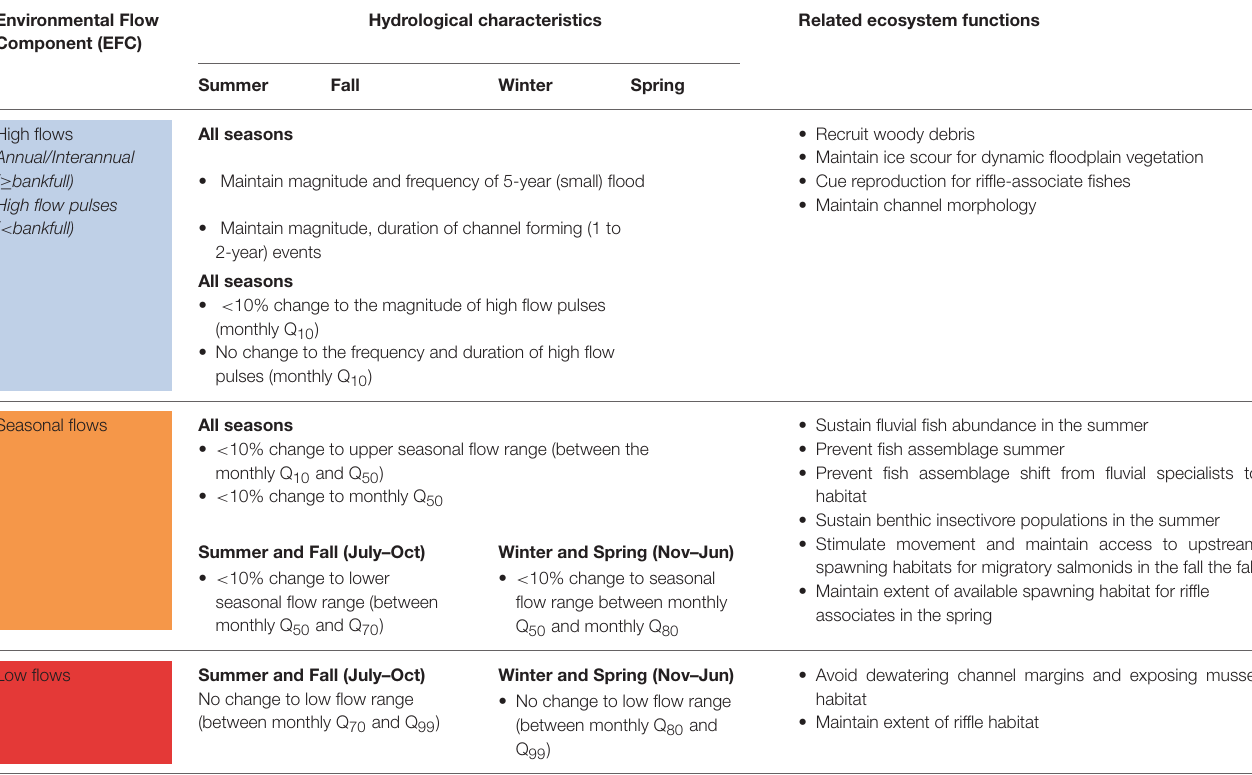
TABLE 4 | A sample of the flow recommendations from a Level 2 process for all small rivers (drainage areas of 130 – 500 square kilometers) in the Great Lakes catchments of New York and Pennsylvania, USA. Environmental Flow Component